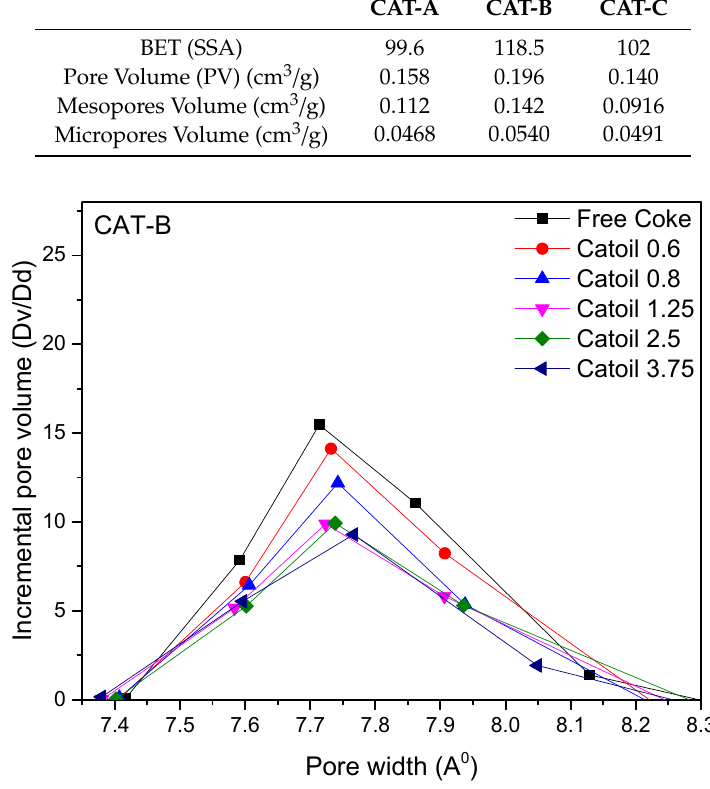
Figure 5. Di ff erential pore volume (dV / dD) as a function of the pore diameter (D) using the Figure 5. Differential pore volume (dV/dD) as a function of the pore diameter (D) using the N 2 - N 2 -adsorption isotherms. ( (cid:4) ) CAT-B free of coke; ( (cid:8) ) CAT-B at C / O = 0.6 g / g; ( (cid:78) ) CAT-B at C / O adsorption isotherms. ( ■ ) CAT-B free of coke; ( ● ) CAT-B at C/O = 0.6 g/g; ( ▲ ) CAT-B at C/O = 0.8 g/g; = 0.8 g / g; ( (cid:72) ) CAT-B at C / O = 1.25 g / g; ( (cid:7) ) CAT-B at C / O = 2.5 g / g; and ( (cid:74) ) CAT-B at C / O = 3.75 g / g. All ( ▼ ) CAT-B at C/O = 1.25 g/g; ( ♦ ) CAT-B at C/O = 2.5 g/g; and ( ◄ ) CAT-B at C/O = 3.75 g/g. All samples samples were analyzed following catalytic cracking runs at 550 ◦ C and 7 were analyzed following catalytic cracking runs at 550 °C and 7 s. Table 5. Specific surface areas (SSA) (m 2 /g) and pore volumes (PV) (cm 3 /g). Mesopore volumes (cm 3 /g) for CAT-B are determined following catalytic cracking runs at 550 °C and 7 s, using different C/O ratios. SD on repeats: +/ − 3 m 2 /g.